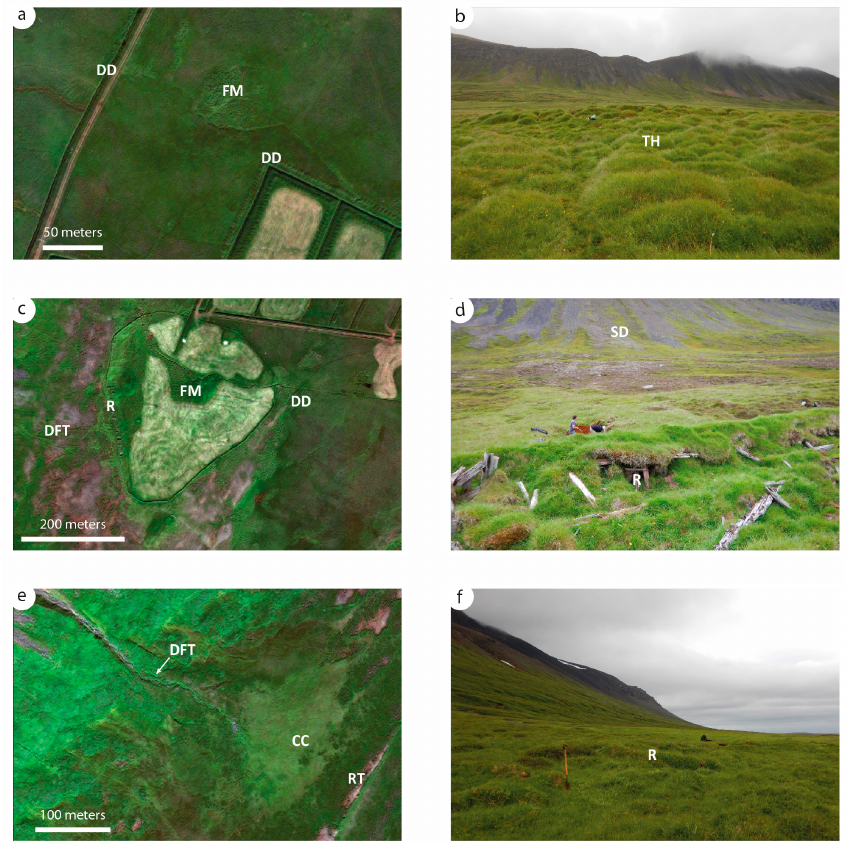
Figure 2. Left : satellite images of the three study areas; Right : view from the farms relative to the slopes of Mt. Flautafell from the ground. a–b : Norður Hús, c–d : Flautafell, e–f : Stekkur. Source of satellite imagery: DigitalGlobe. DD: drainage ditches, FM: farm mound, TH: Thúfur, DFT: debris-flow track, R: ruins, SD: slope deposits, CC: colluvial cone, RT: river terrace.